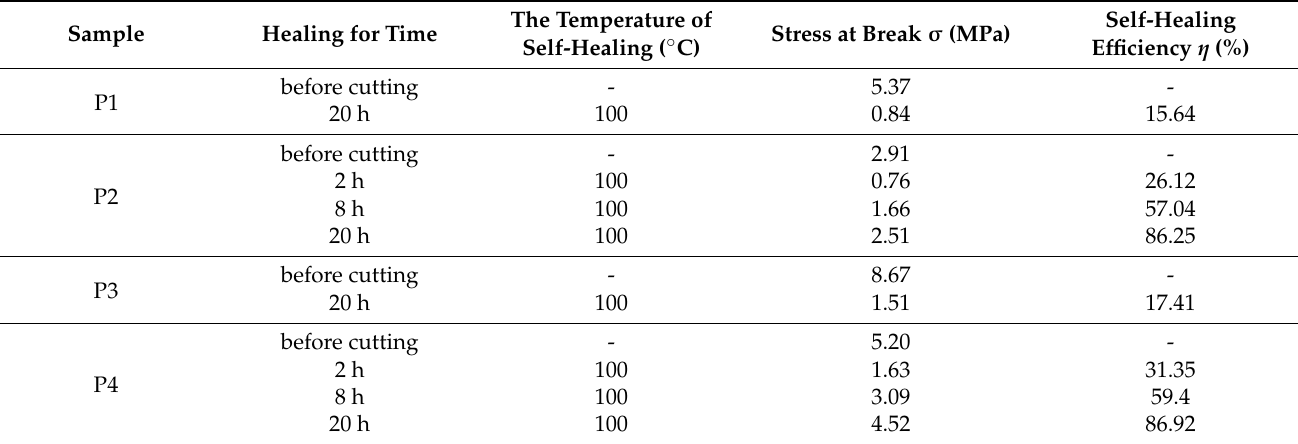
Table 4. Film self-healing